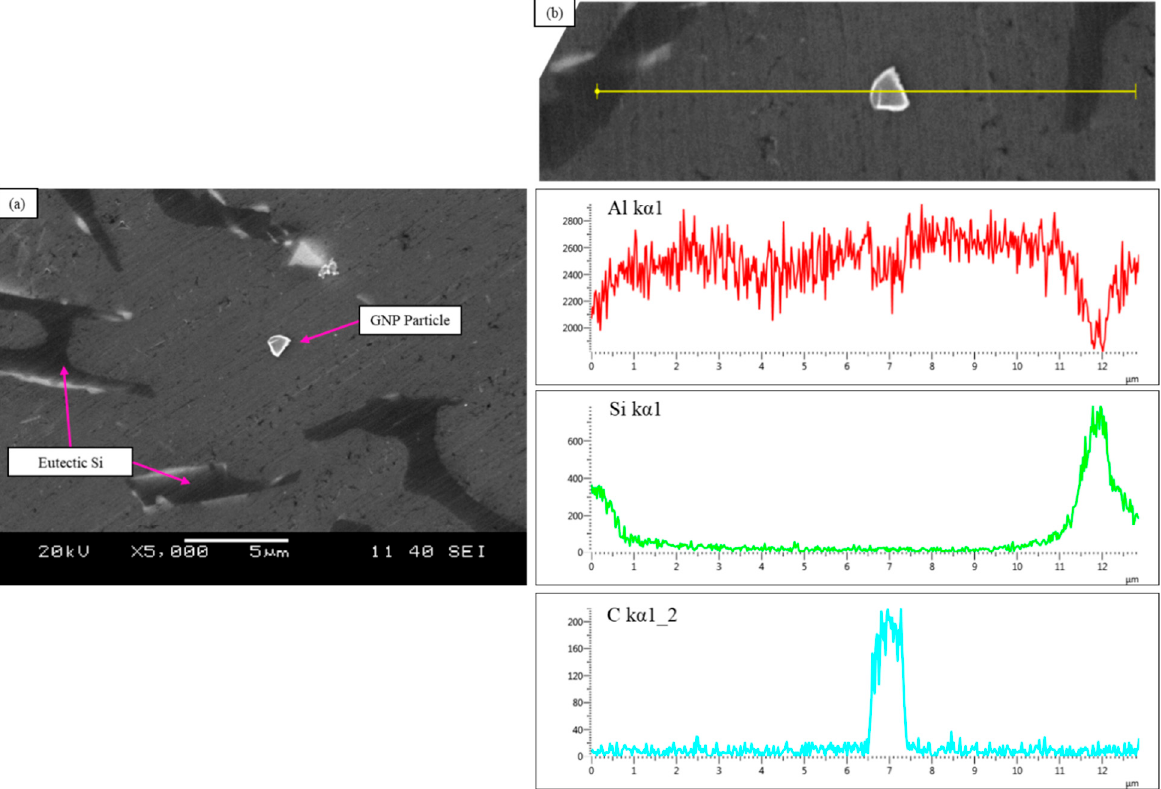
Figure 4. ( a ) Secondary electron image of GNP particle and ( b ) corresponding EDX linescan for A319 + 0.05 GNP + SS + UST composite.